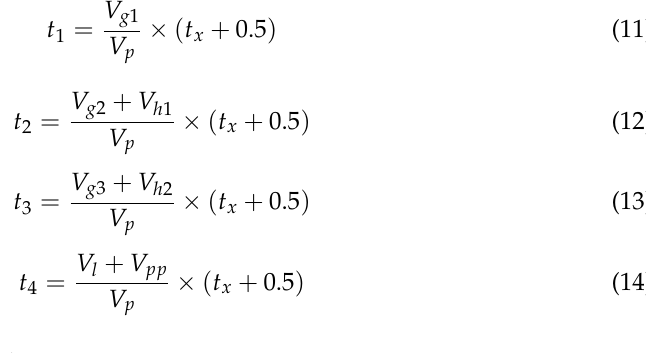
Table 9. Formula (10) symbols and meanings. Symbol Unit Meaning T 1 , T 2 , T 3 , T 4 ◦ C corn average temperature in each tempering section min